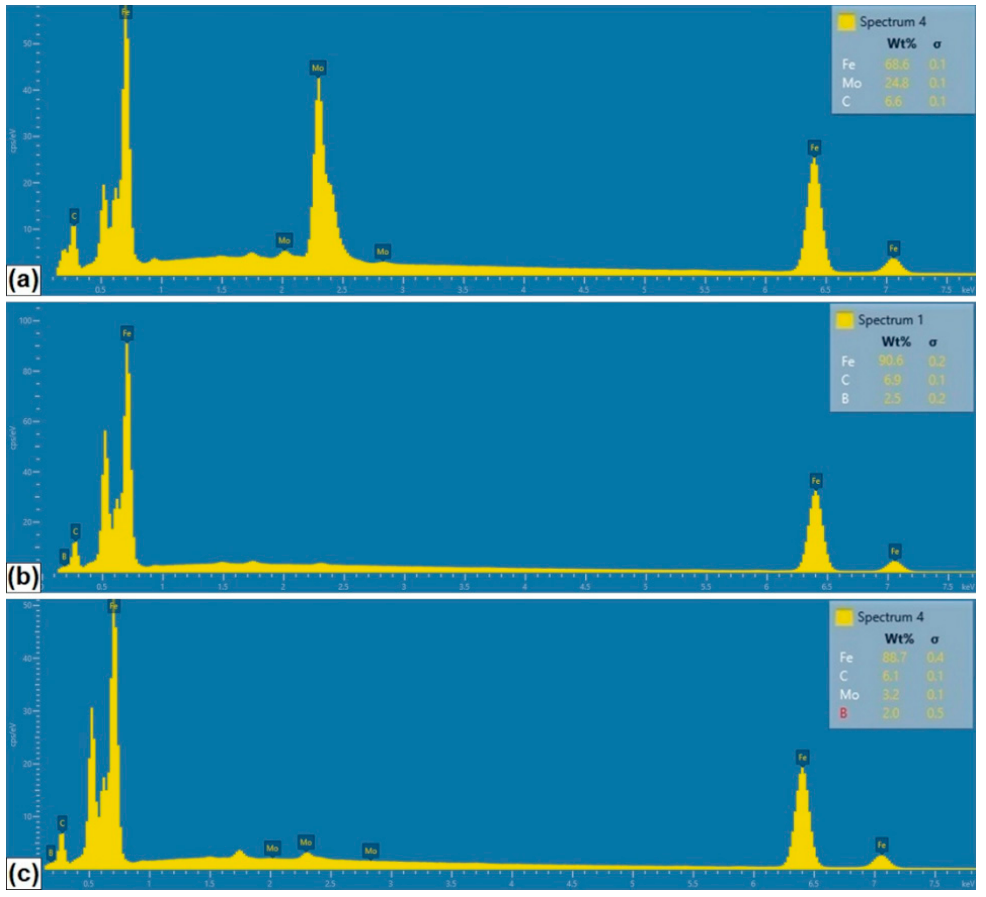
Figure 4. EDS spectrum of produced: ( a ) Mo coating; ( b ) B coating; ( c ) Mo-B coating.